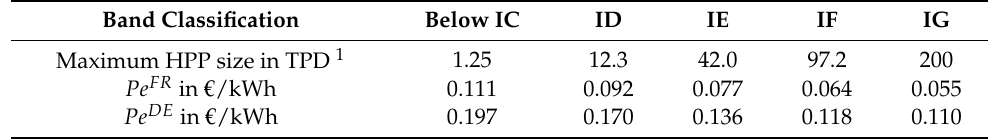
Table 2. Maximum production plant (HPP) size for different non-household consumers (band). Band